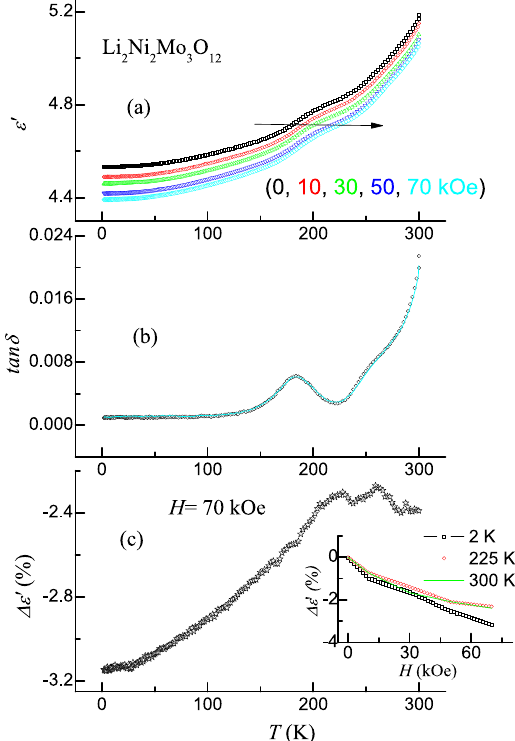
Figure 3. (a) Dielectric constant and ( b ) tan δ in zero field and in various magnetic fields (10, 30, 50 and 70 kOe), measured with 70 kHz, for Li 2 Ni 2 Mo 3 O 12 . In ( b ), data points correspond to zero field, while in-field behavior (70 kOe) is represented by a continuous line. Both these curves overlap. (c) Magnetodielectric effect ( Δ ɛ ′ ) for a change of magnetic field from zero to 70 kOe as extracted from the data shown in ( a ). Inset of ( c ) shows Δ ɛ ′ versus H for some selected